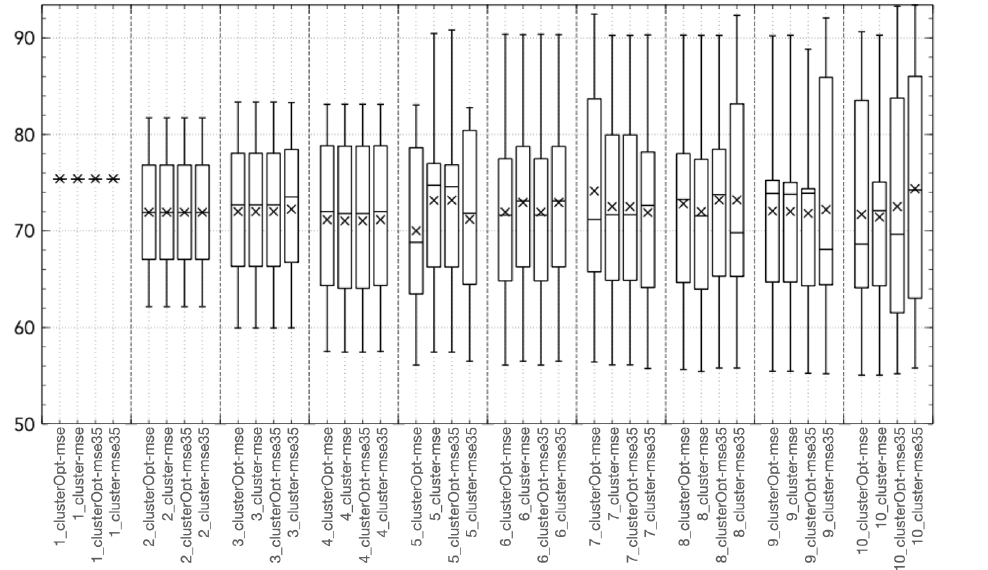
Figure 6. Boxplot of coordinate 4 ( u 3 ( t ) , daily mean humidity at time t ) of the centroid [ % ]